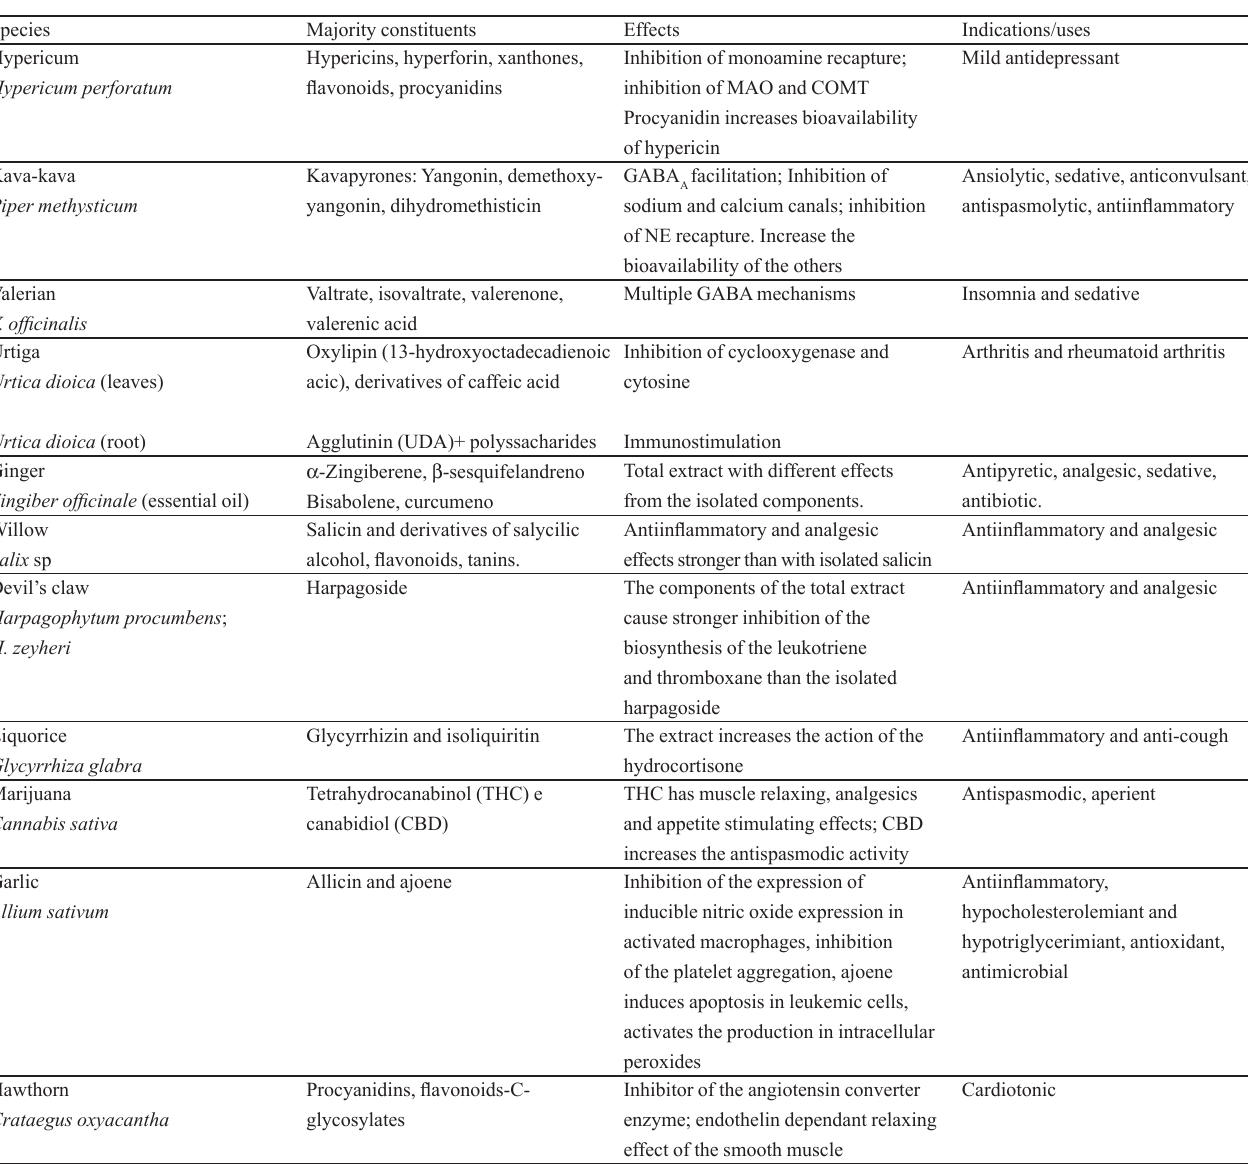
TABLE I - Plant extracts with evidence of synergic/polyvalent